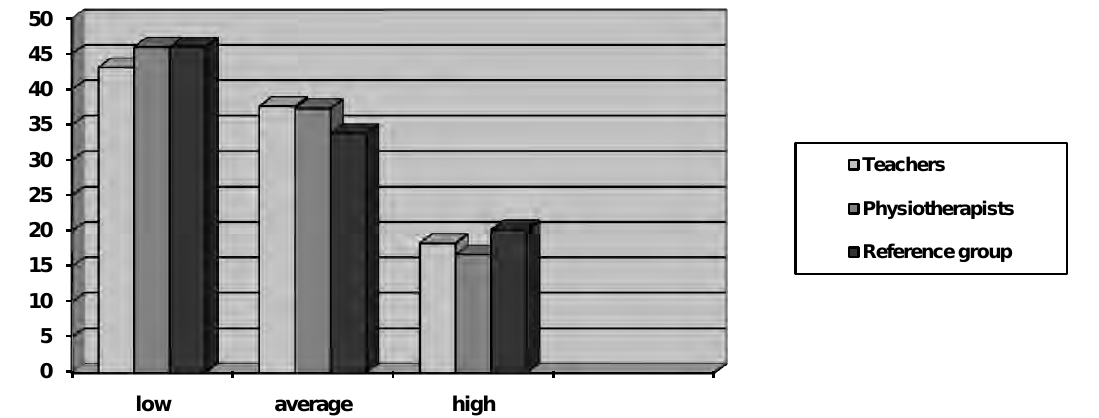
Fig.1. Level of the women’s emotional intelligence and the studies department